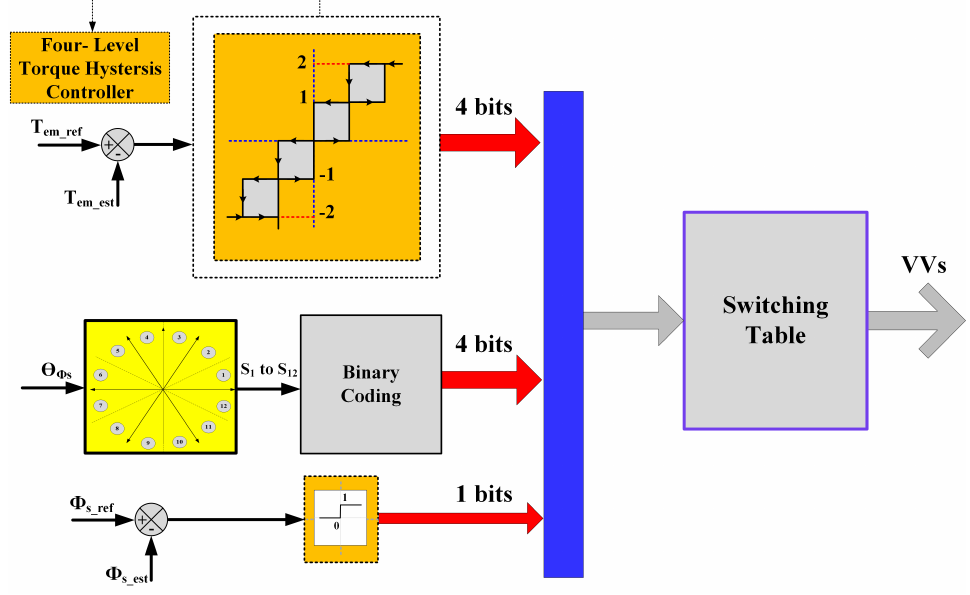
Figure 3. The block diagram of the proposed